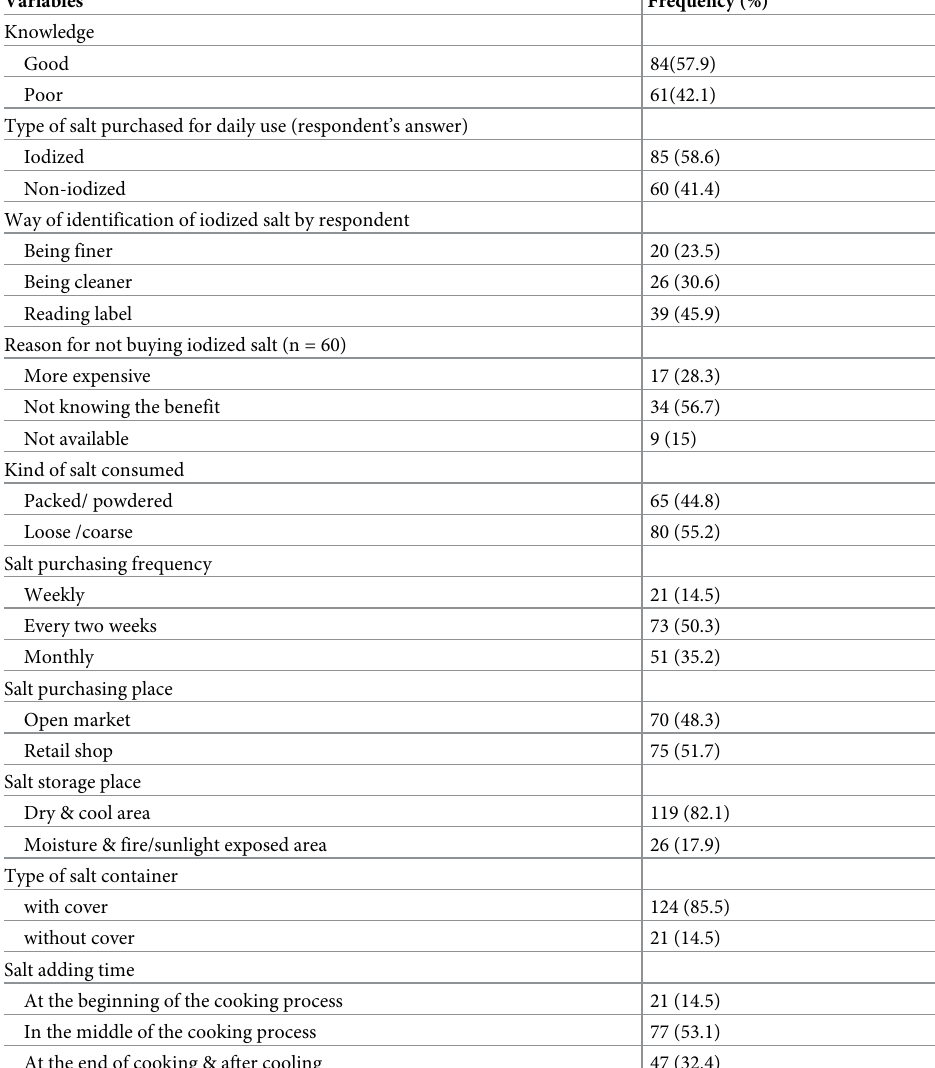
Table 2. Knowledge & practice of pregnant women on iodized salt utilization (N = 145) in BUNMAP cohort study, Butajira, Ethiopia, February